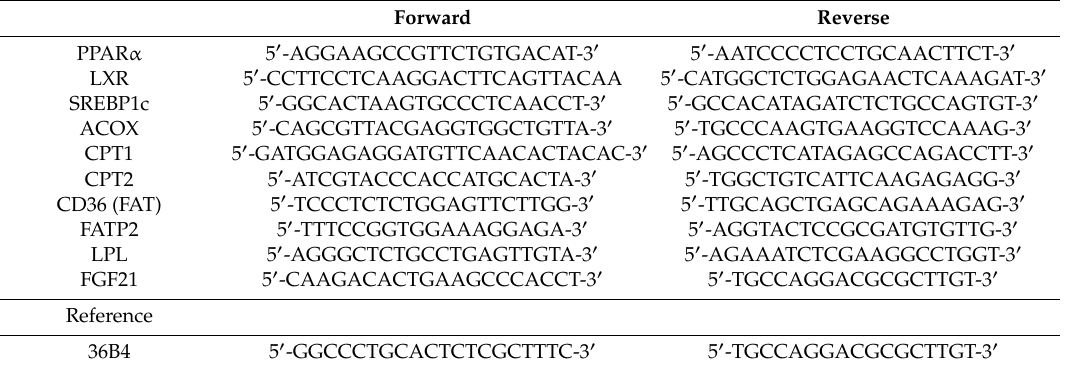
Table 2. Primers used in the real-time reverse transcription polymerase chain